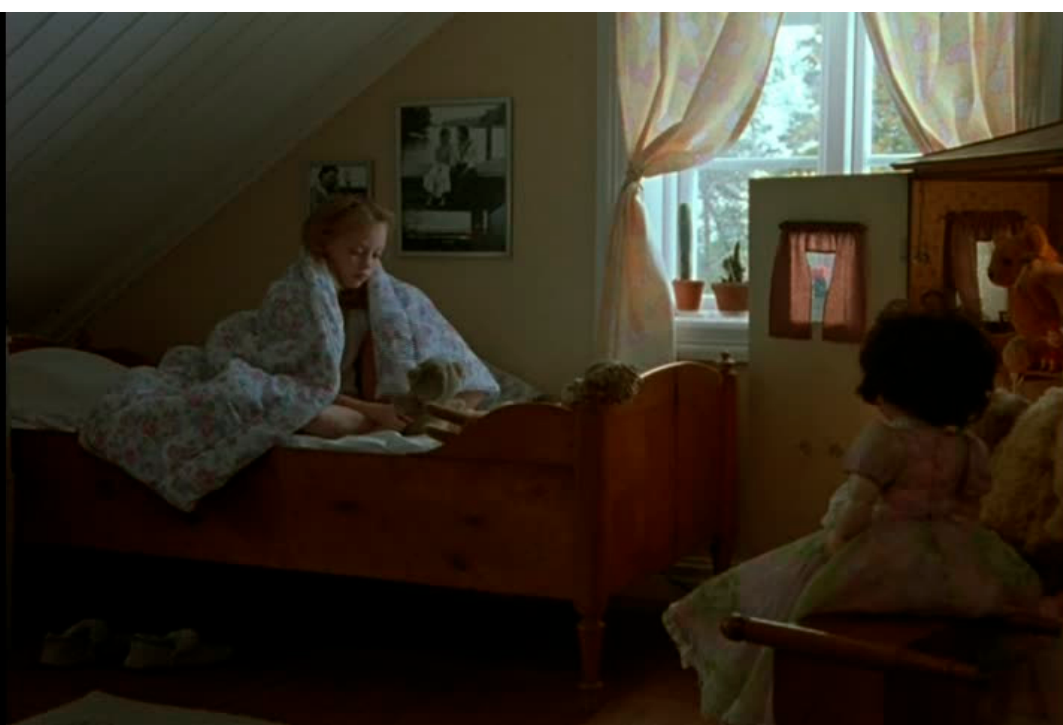
Figure 9. …telling of a nightmare.